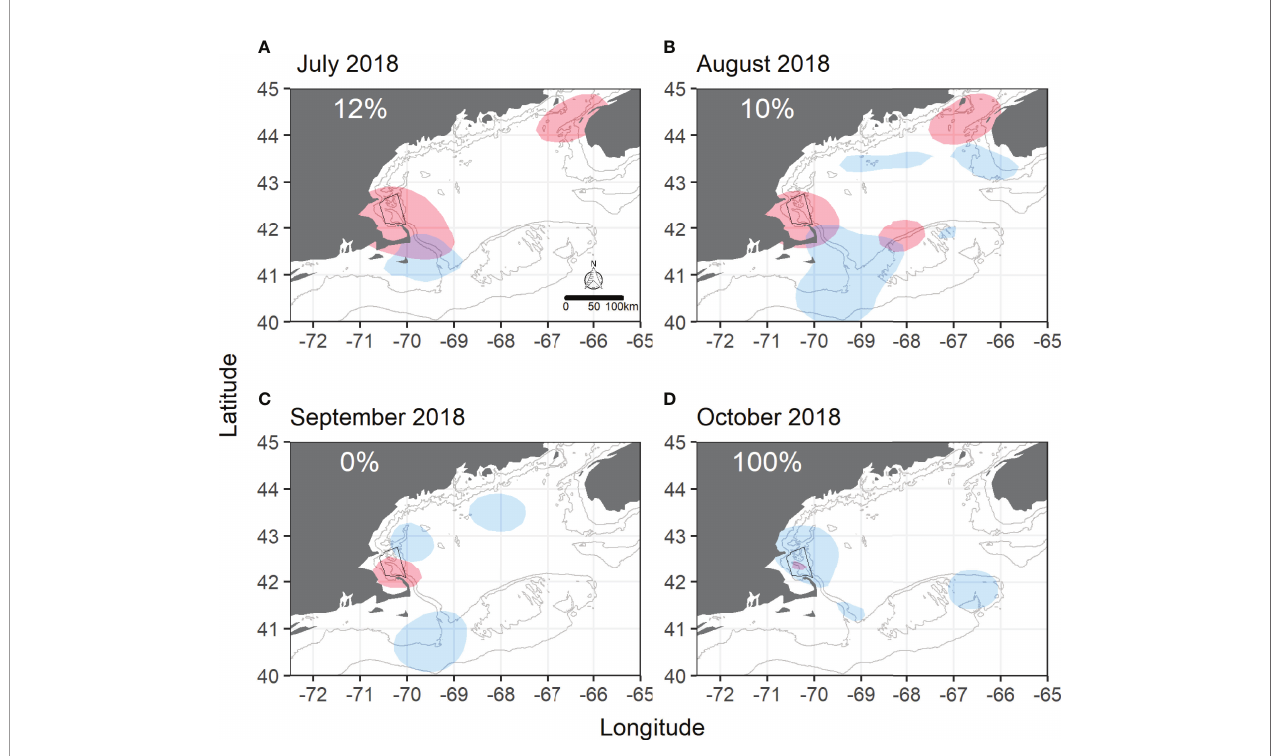
FIGURE 3 | Monthly overlap between great shearwaters and humpback whales at the Gulf of Maine scale using satellite telemetry data in 2018. (A) July 2018, (B) August 2018, (C) September 2018, (D) October 2018. Shaded blue areas are shearwater utilization distributions (GOM-wide) from 50% kernel density isopleths. Shaded red areas are humpback whale utilization distributions from 50% kernel density isopleths. SBNMS boundaries are in black. Gray lines represent 50m and 100m depth contours. Percentages represent the percentage of the humpback whale UD overlapping with the shearwater UD.